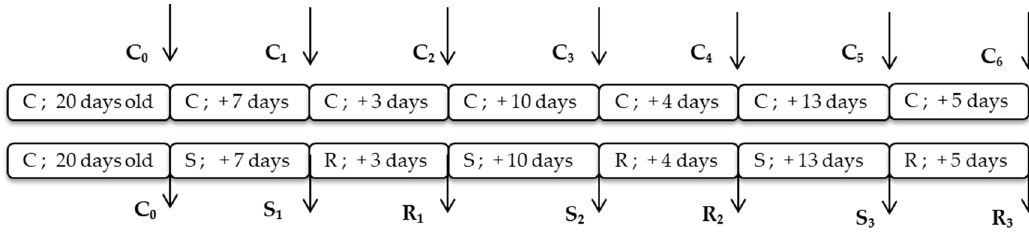
Figure 2. States of the drought stress experiment [5].